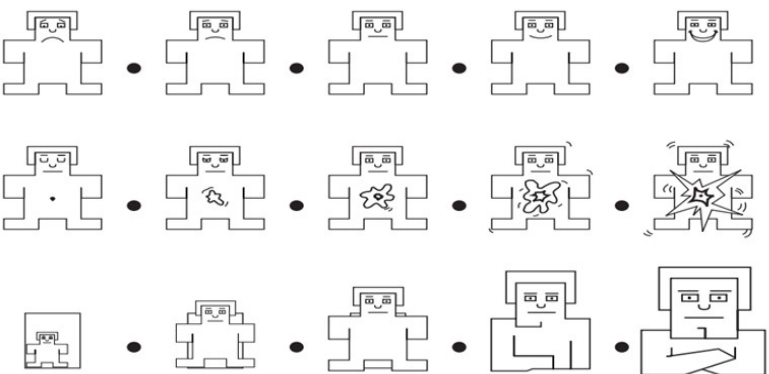
Figure 2. Images used for self-assessment: ( top ) Valence self-assessment manikin (SAM); ( middle ) Arousal SAM; ( bottom ) Dominance SAM.